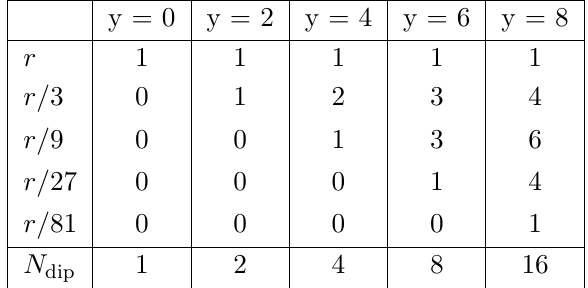
Table 2. Approximate behaviour of dipole evolution for four generations of dipoles. The number of dipoles in column n row k is equal to the binomial coe(cid:14)cient